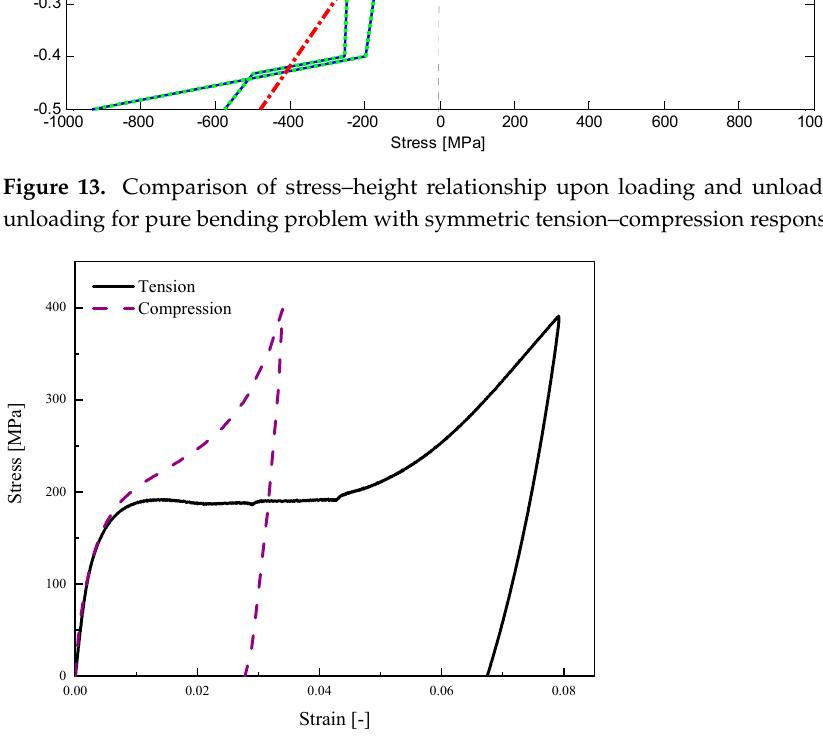
Figure 13. Comparison of stress–height relationship upon loading and unloading with elastic un- loading for pure bending problem with symmetric tension–compression response [28].